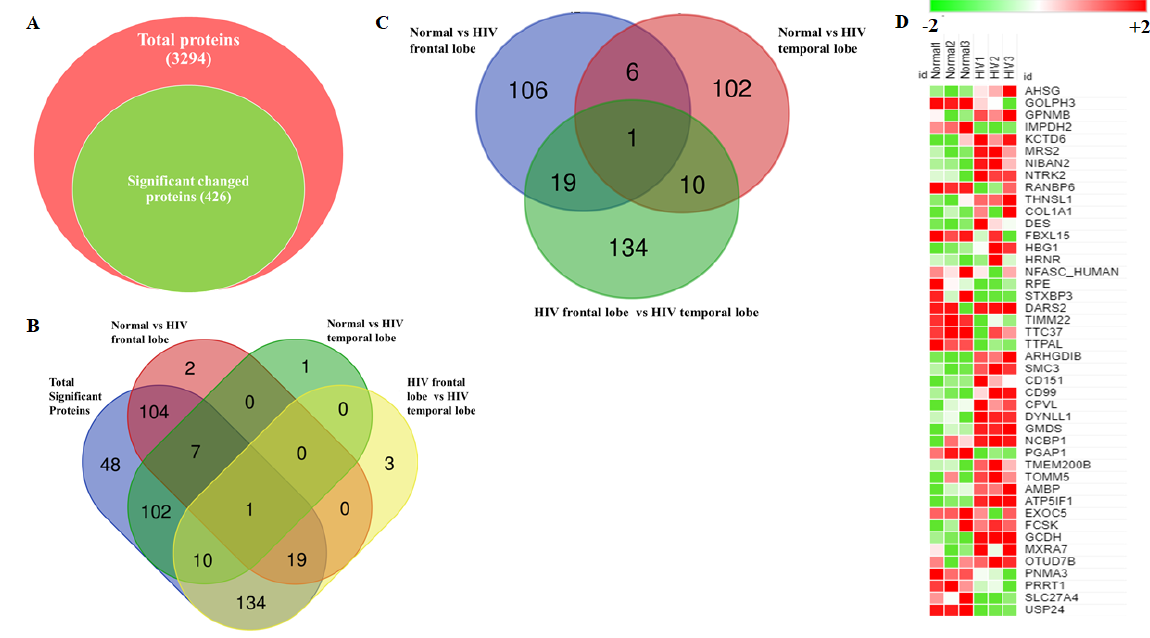
Figure 2. ( A ) The Venn diagram represents a comparison of significantly differentially expressed proteins in HIV+ brain tissue compared to normal groups. A total of 426 proteins were significantly expressed out of 3294 total proteins identified by proteomic analysis. ( B ) The Venn diagram used to compare and determine shared proteins with significant changes among four comparison groups: total significant proteins, normal frontal vs HIV+ frontal proteins, normal temporal vs HIV+ temporal proteins, and HIV+ frontal vs HIV+ temporal proteins. ( C ) The Venn diagram used to compare and determine shared proteins with significant changes between normal frontal vs HIV+ frontal lobes, normal temporal vs HIV+ temporal lobes, and HIV+ frontal vs HIV+ temporal lobes. ( D ) The heatmaps represent the top 50 up and downregulated proteins in HIV+ groups compared with normal groups for both frontal and temporal brain regions.